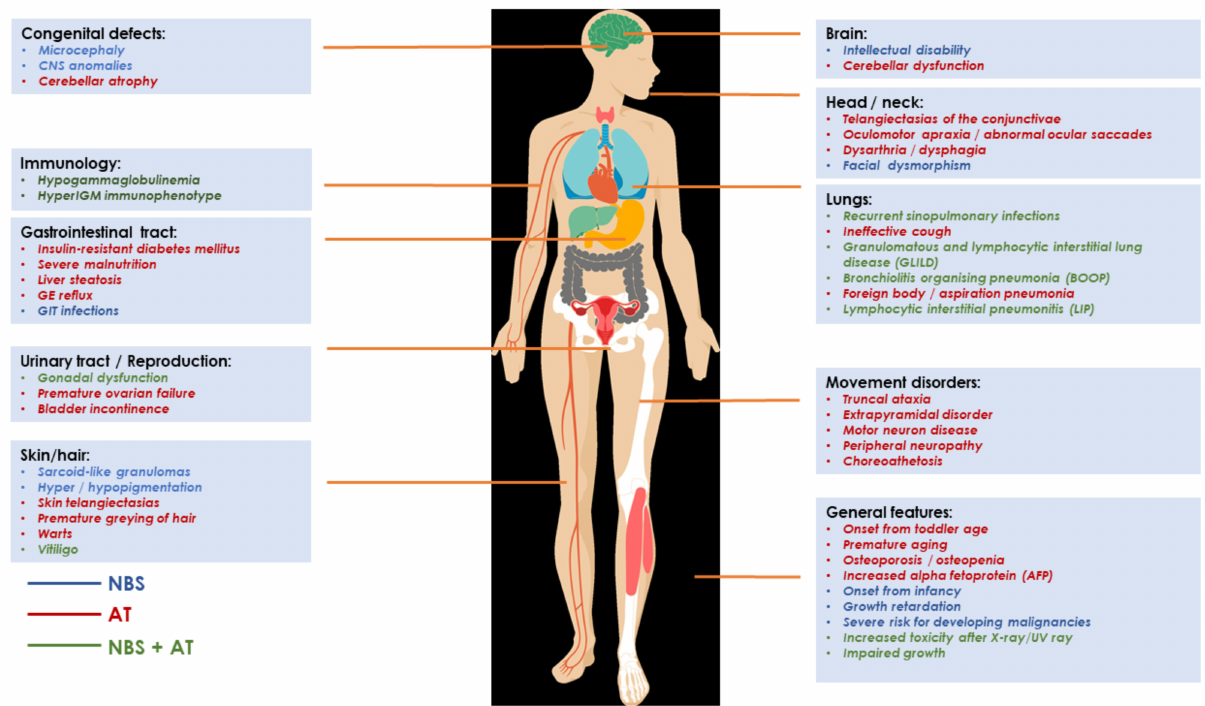
Figure 1. Phenotypic features of Nijmegen breakage syndrome (NBS) and Ataxia Telangiectasia (AT). The colour of the font represents specific syndrome: blue—NBS; red—AT; green—both NBS and